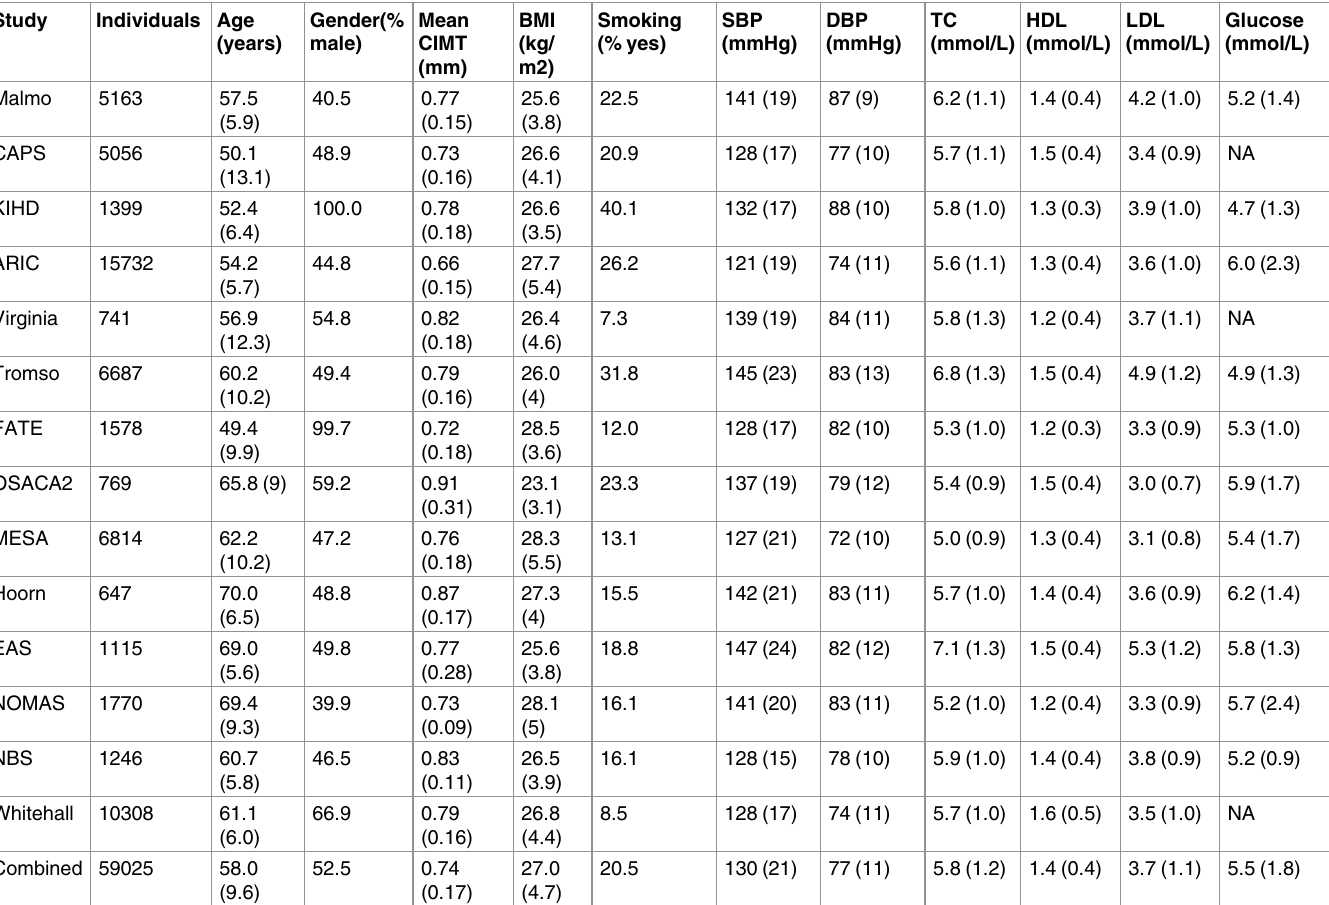
Table 1. Baseline characteristics of USE-IMT cohorts in the present